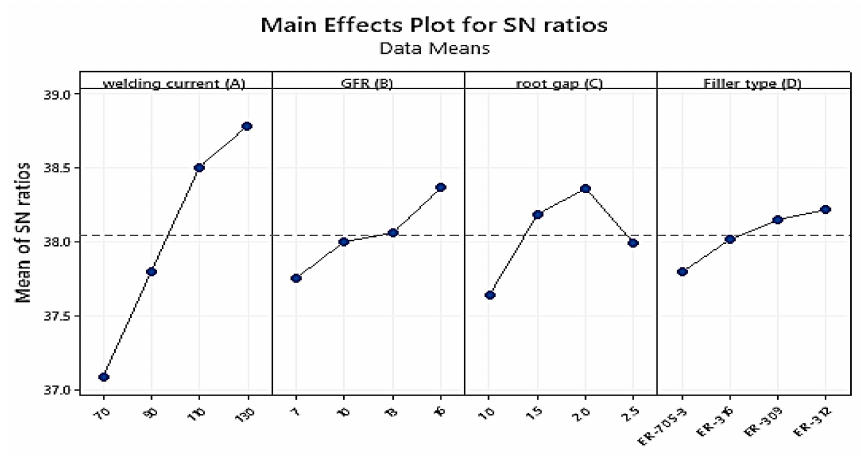
Figure 20. Main effect plot for signal-to-noise ratios for Hardness.